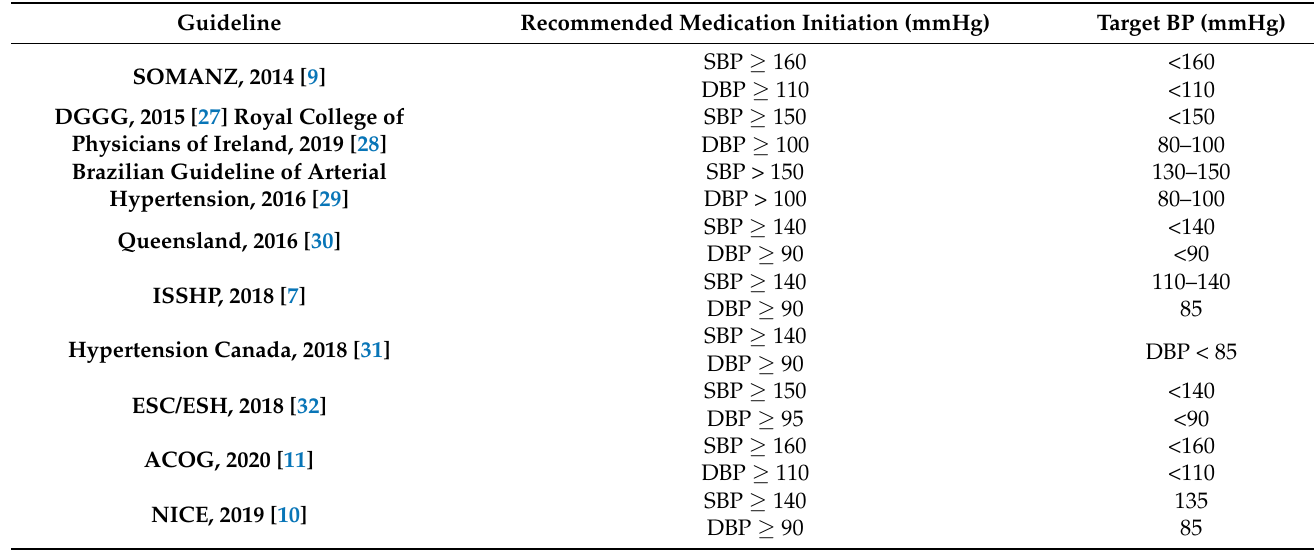
Table 2. Indications for starting antihypertensive medication in pregnancy, and blood pressure goals in the hypertensive disorders of pregnancy in national and international